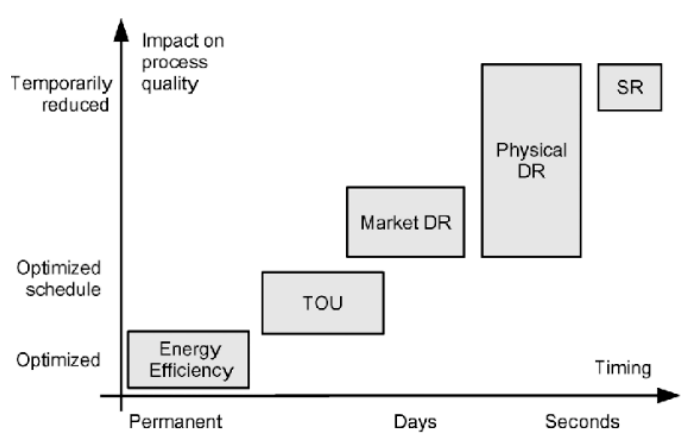
Figure 1. Demand Side Management Categories